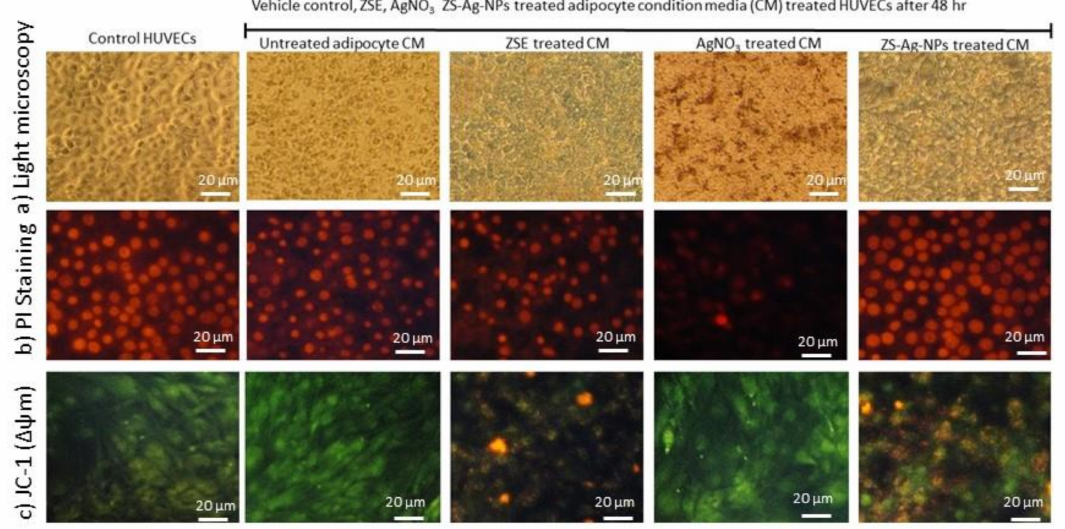
Figure 7. Analysis of the vehicle control, ZSE, AgNO 3 , and ZS-Ag-NPs treated adipocytes condition media supplemented HUVECs on cell morphology by light microscopy ( a ), PI Staining for nuclear damage ( b ) and JC-1 staining for mitochondrial membrane potential ( c ) after 48